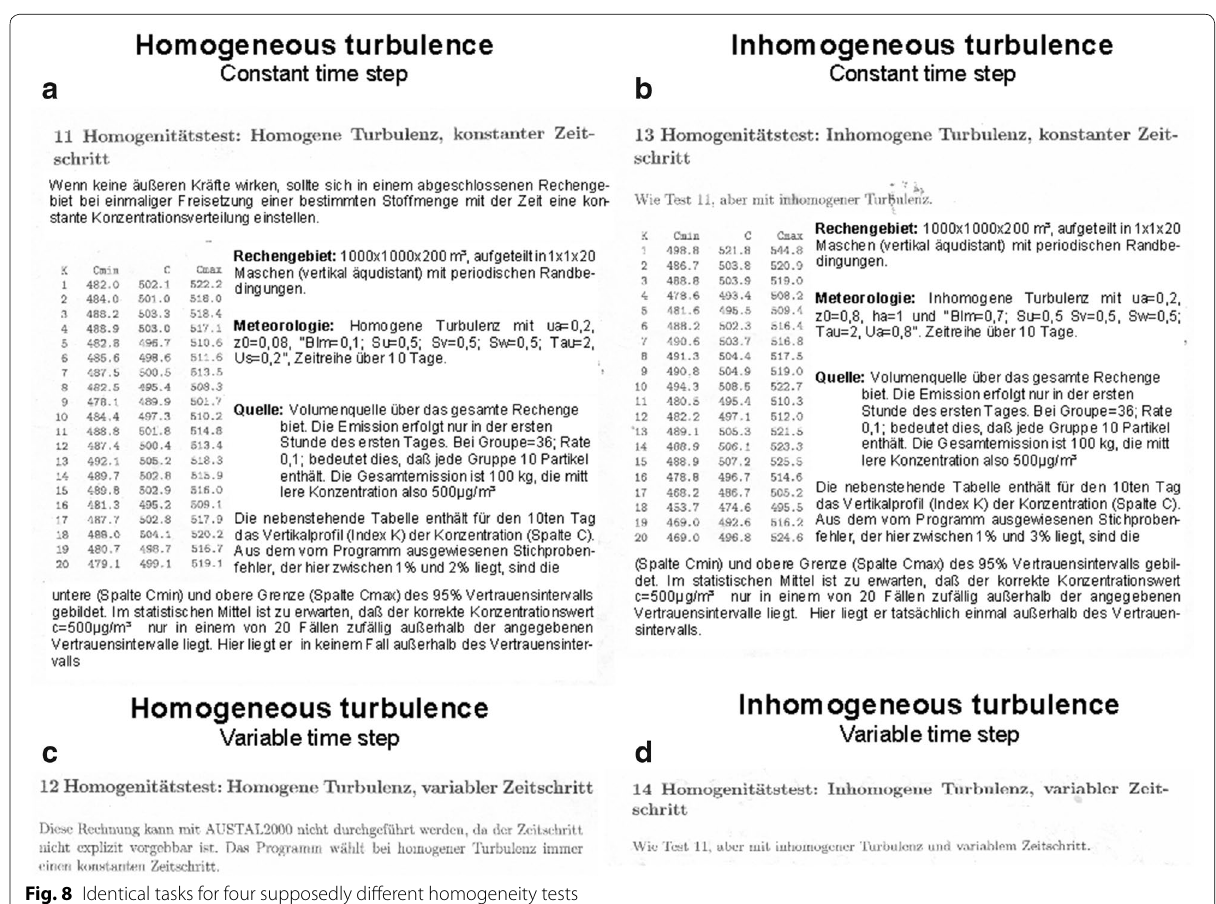
Fig. 8 Identical tasks for four supposedly different homogeneity